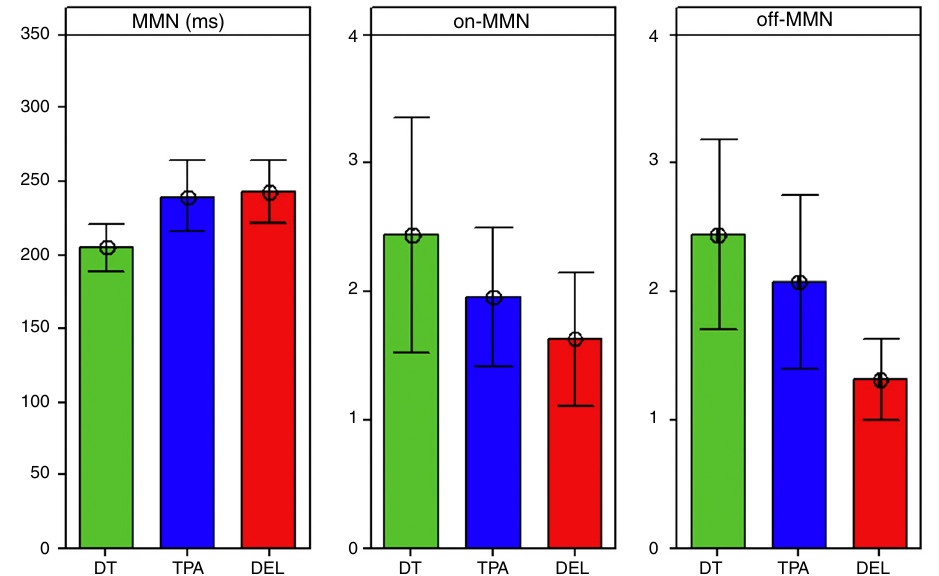
Comparison between the means of the three groups for latency and mismatch negativity (MMN) amplitude. TD, typical development; APD, auditory processing disorder; SLI, specific language impairment.